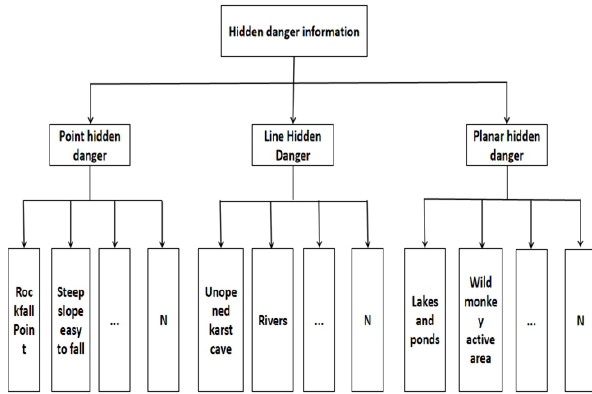
Figure 2. Information Division Map of Security